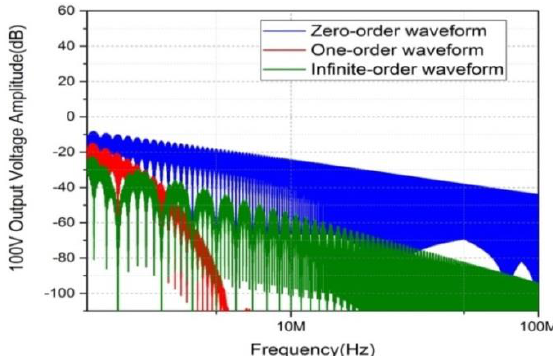
Figure 2. Spectra comparison of zero-order waveform (square signal), one-order waveform (trapezoidal signal) and infinite-order waveform (Gaussian signal).